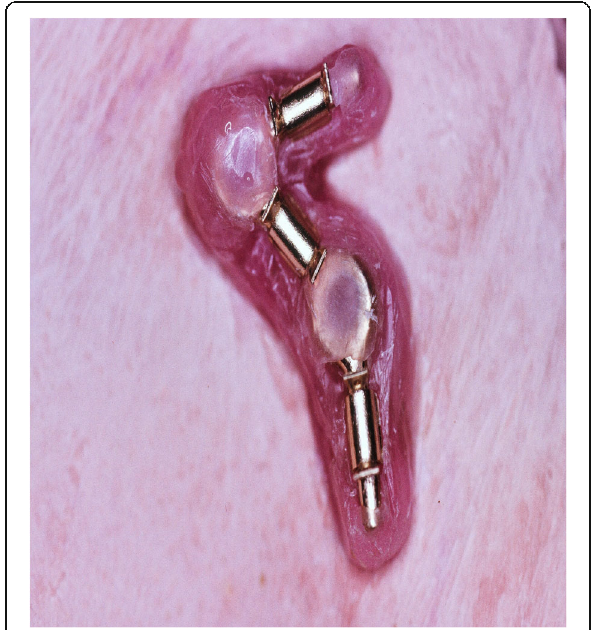
Fig. 9 Retention clips blocked out on the bar